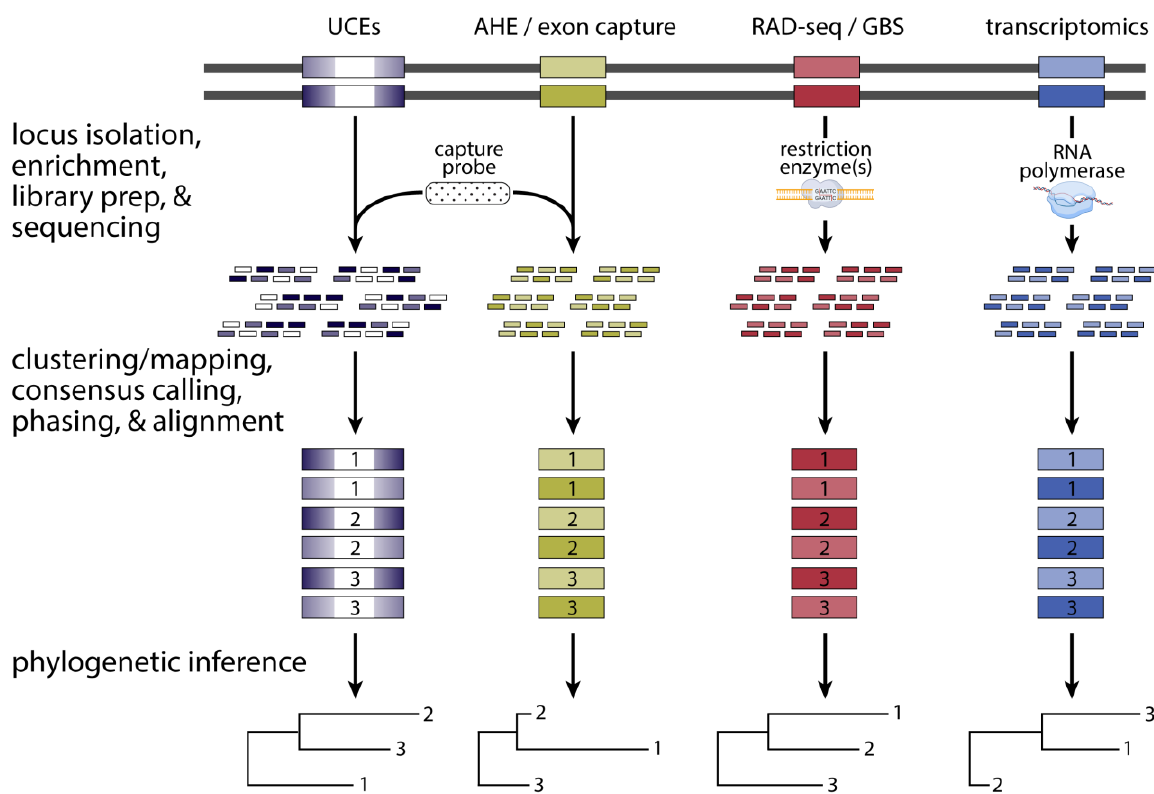
Figure 4. Graphical overview of various reduced representation approaches used in phylogenomics investigations. Alternative depictions are presented for different methods of enriching for particular loci in the genome: two kinds of target capture (targeting UCEs and AHEs or exons), RAD-seq (also known as GBS), and transcriptomics. In each case, the color indicates the location of phylogenetically informative signal in the locus, which typically comprises the whole extent of the target locus, except in the case of UCEs, where this signal is found in the regions flanking the locus. These classes of loci, or markers, are depicted along a diploid genome for a single sample, with heterozygous variation in the form of two alleles at each locus indicated with alternative shading. Although only a single sample is indicated, these approaches would be applied to all samples of interest in parallel, ultimately resulting in sequencing for all samples (e.g., N = 3 samples depicted below). For target capture, the genome is fragmented, and oligonucleotide probes are used to enrich for the target loci. For RAD-seq and transcriptomics, regions of interest are isolated and enriched simultaneously by restriction enzymes and cellular RNA polymerase transcription activity followed by in vitro reverse transcription, respectively. Importantly, of the three general methods, only target capture requires a priori sequencing data and knowledge to construct oligonucleotide probes. After this isolation and enrichment step, all methods proceed generally the same way with standard library preparation and sequencing steps. The resulting sequencing data are also generally analyzed similarly by bioinformatically parsing data to recover sample-specific sequences (three samples are indicated) and clustering sequences by similarity to enable consensus calling (not shown), although a reference genome can aid in this process. Variation across loci is ideally phased to recover the original heterozygous state — two phased alleles per sample are depicted. Phased sequence data for each sample and locus can then be aligned and used for phylogenetic inference.